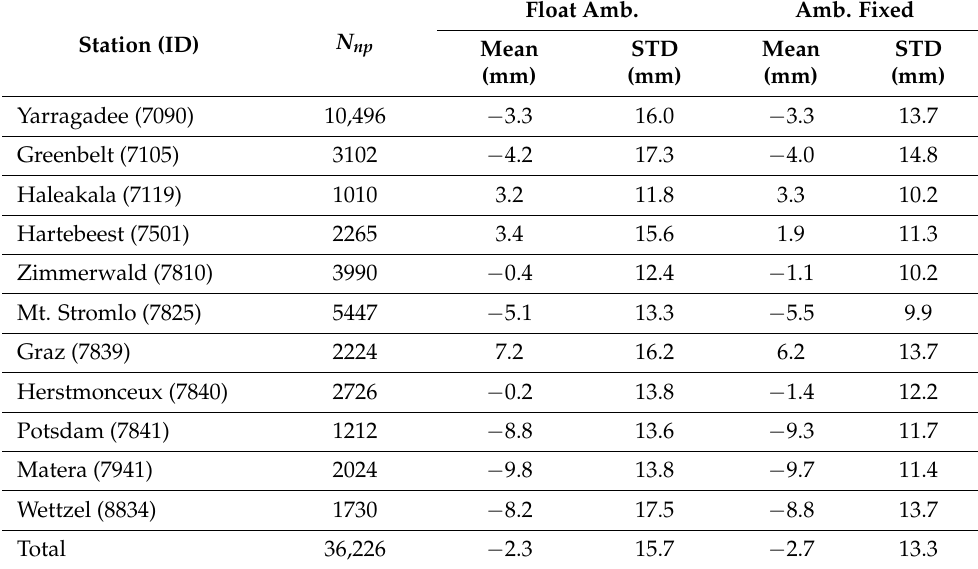
Table 5. SLR residuals and number of normal points for 11 high-performance ILRS stations used for the validation of the HY-2B orbit. Float N np